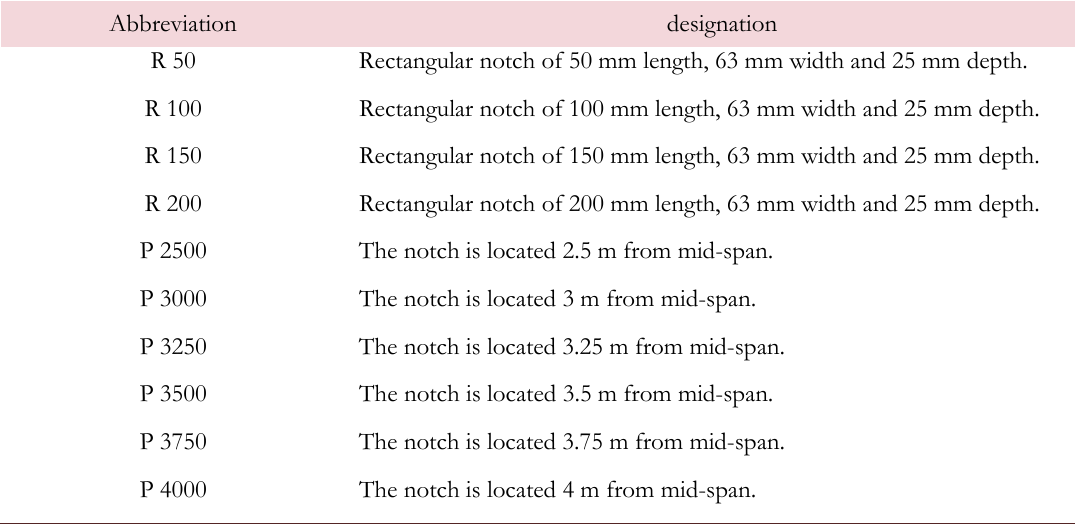
Table 6: the abbreviations adopted in the